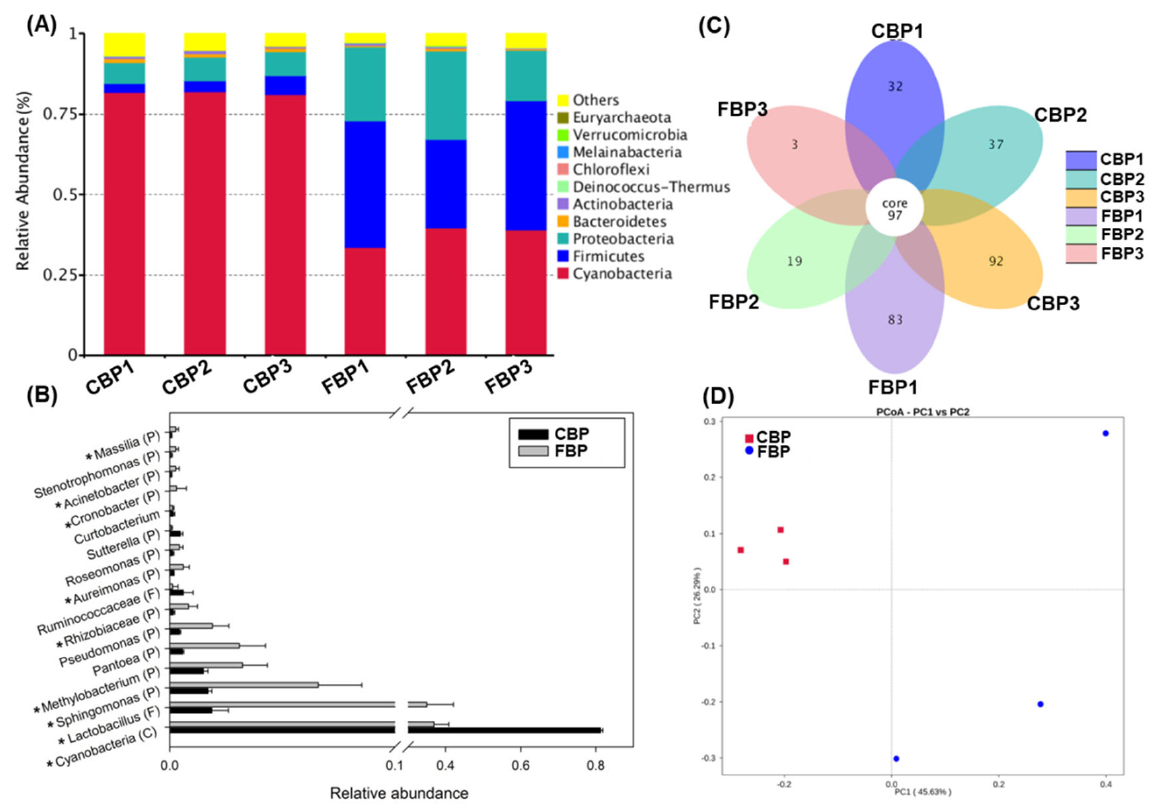
Figure 4. Bacterial community structure and composition in the raw B. papyrifera (CBP) and the Lp − fermented B. papyrifera product (FBP) under practical condition. ( A ) Relative abundance at phylum level, ( B ) flower diagram, ( C ) dominant genus, and ( D ) PCA plot. * indicates significant difference between the two groups at p < 0.05.